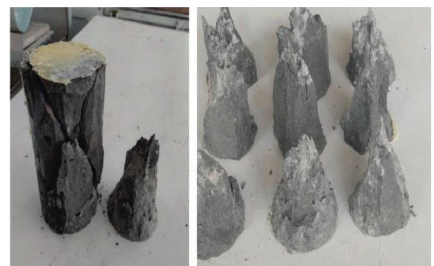
Figure 2: Concrete samples after compressive test.